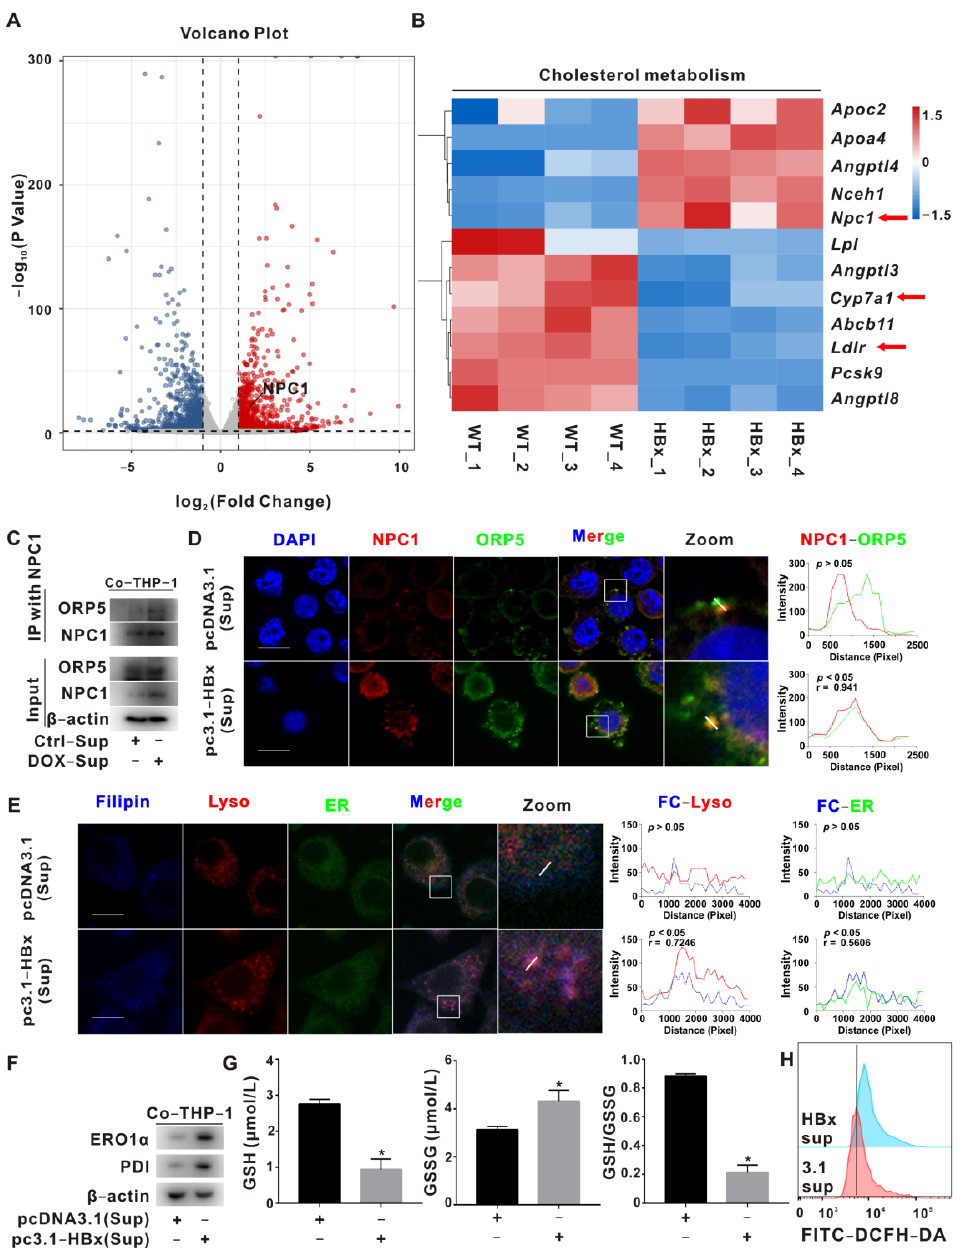
Figure 2. NPC1-mediated Lyso-ER cholesterol transport to regulate ER redox and ER stress homeosta- sis. ( A , B ) Transcriptomic analysis of livers from HBx-Tg mice. ( A ) The volcano plot of DEGs presents red points for upregulated genes ( n = 859) and blue points for downregulated genes ( n = 1066). The upregulation of the Npc1 gene is shown. ( B ) The heatmap of DEGs (cholesterol metabolism) in the liver tissues from HBx-Tg mice ( n = 4) and WT mice ( n = 4). Arrows indicate the cholesterol-related genes screened in this study. ( C ) Co-immunoprecipitation detection of NPC1-ORP5 interaction level. ( D ) Representative images are shown to demonstrate the levels of NPC1 (red), ORP5 (green), and colocalization (yellow) between NPC1 and ORP5 ( Left ). Fluorescence profile curves were generated using Zen 2010 software ( Right ). DAPI (blue) was used for nucleus staining. Scale bar 10 µ m. ( E ) Representative images are shown to demonstrate the levels of free cholesterol (blue), lysosome (red), ER (green), colocalization (purple) between free cholesterol and lysosome, and colocalization (cyan) between free cholesterol and ER ( Left ). Fluorescence profile curves were generated using Zen 2010 software ( Right ). Scale bar 10 µ m. ( F ) WB detection of ER redox signaling protein levels